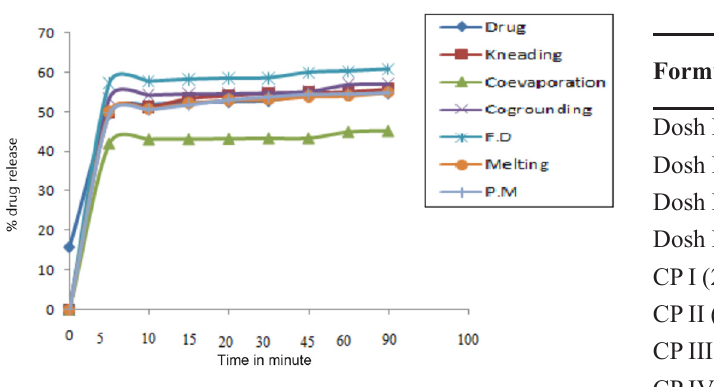
FIGURE 7 - Drug release of drug and its complexes in pH 6.8 phosphate buffer.